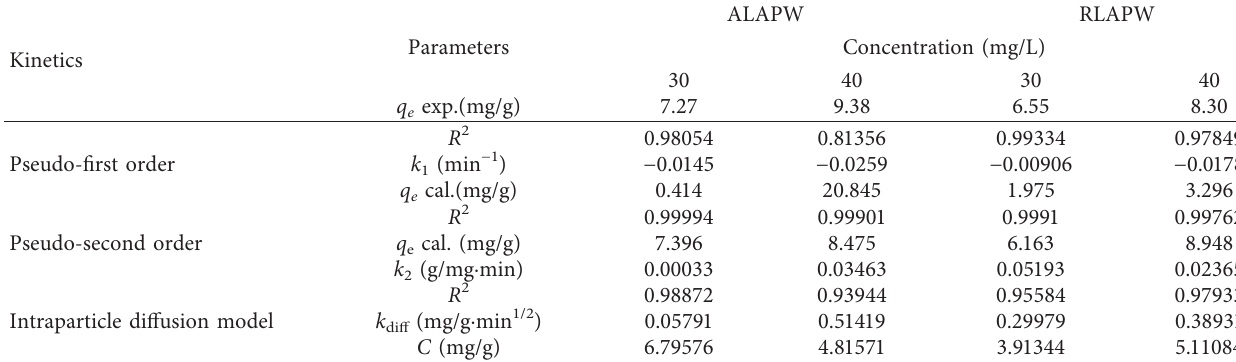
Table 3: Kinetic parameters for MG adsorption onto ALAPW and RLAPW adsorbents.